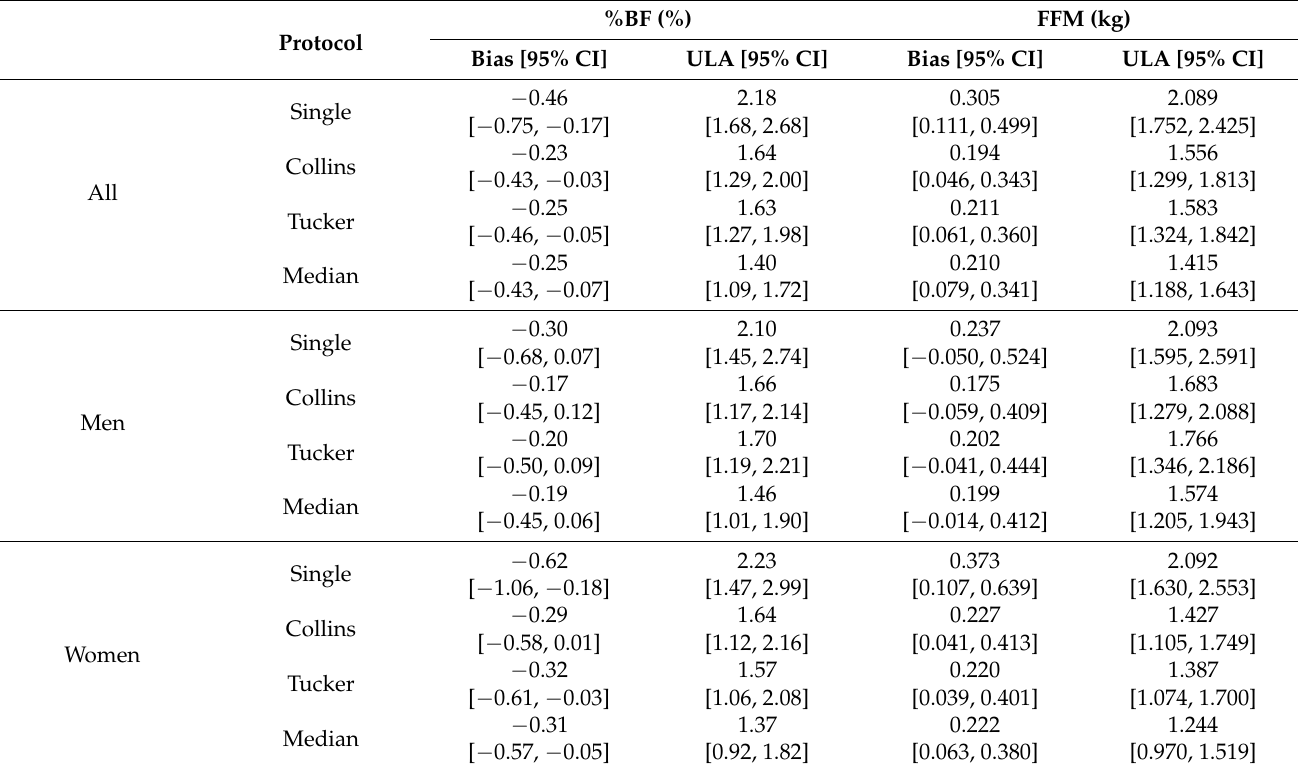
Table 2. BA parameters of the repeatability of %BF and FFM assessments.